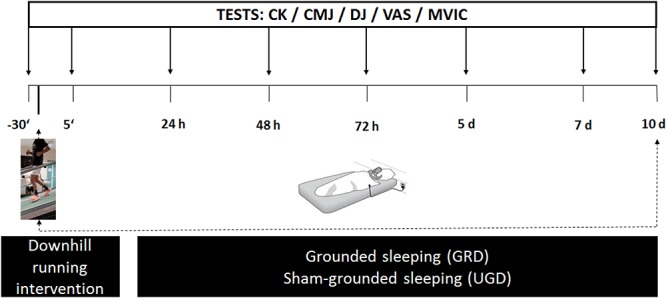
Schematic illustration of the procedure with a timeline: pretest (–30 min prior to intervention), intervention (downhill running), posttests (+5 min, 24 h, 48 h, 72 h, 5 days, 7 days, and 10 days post intervention) consisting determination of blood creatine kinase content (CK), visual analog scale (VAS) related to muscle soreness, drop jump (DJ) performance, counter movement jump performance (CMJ) and a maximum voluntary isometric contraction (MVIC) of both the left and right leg.